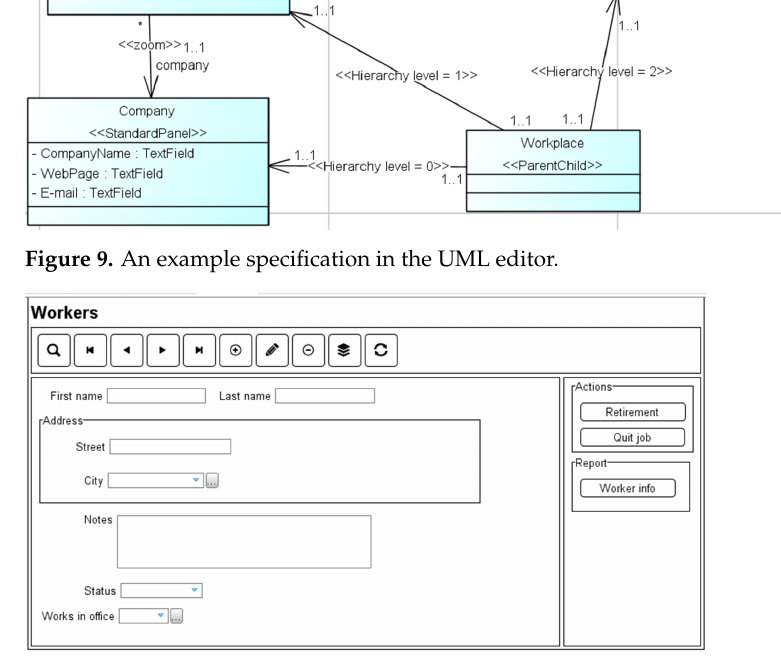
Figure 10. A mockup for managing worker data.